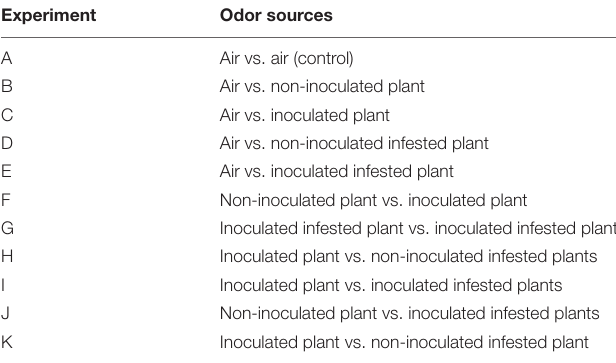
TABLE 1 | Summary of odor sources tested in the Y-tube olfactometer